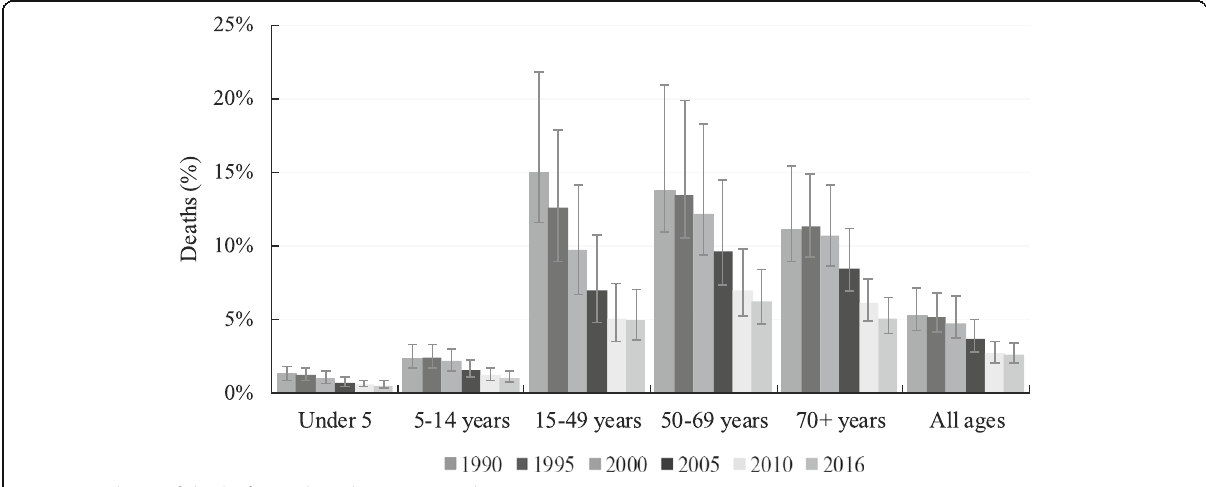
Fig. 2 Prevalence of deaths from tuberculosis in Nigeria by age, 1990 –